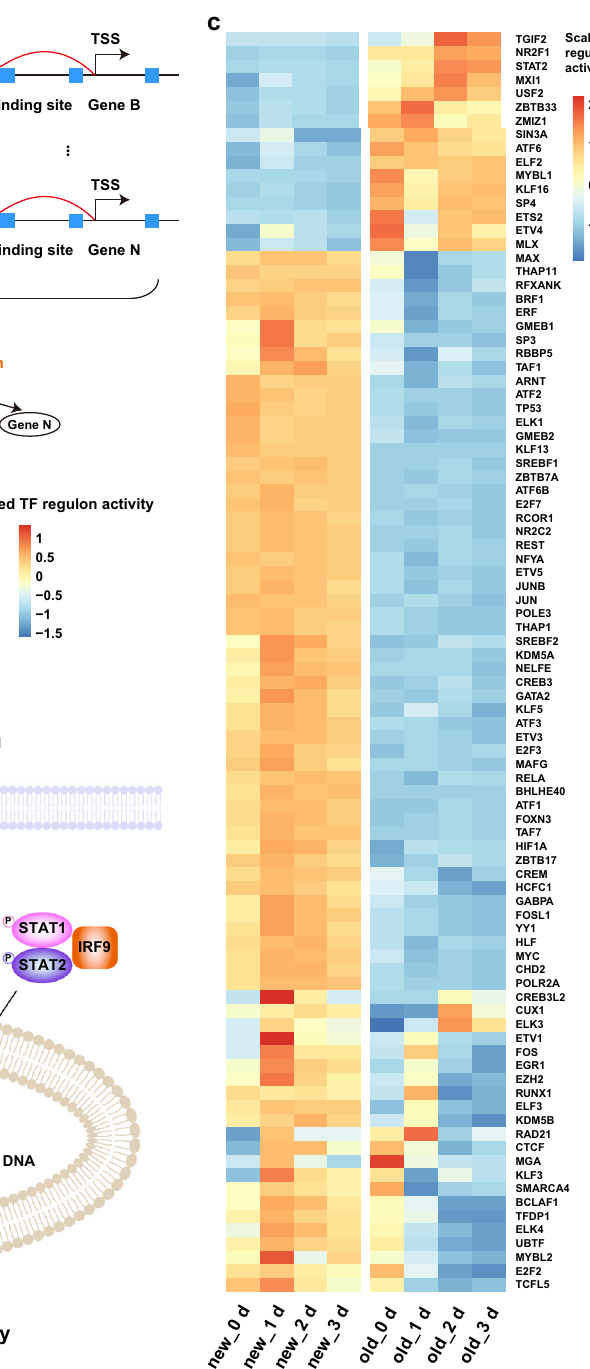
sum test (adjusted P value <0.05, Bonferroni corrected). c Clustered heat map showing the average regulon activity of 92 5-AZA-CdR treatment-independent regulons of HCT116 cells, inferred from either new or old RNAs. d Simpli fi ed dia- gramoftheIFNI/II/III-associatedinductionandreceptorsignalingpathway,leading to the activation of JAK/TYK-STAT pathway and interferon-stimulated antiviral immunity. Source data are provided as a Source Data fi